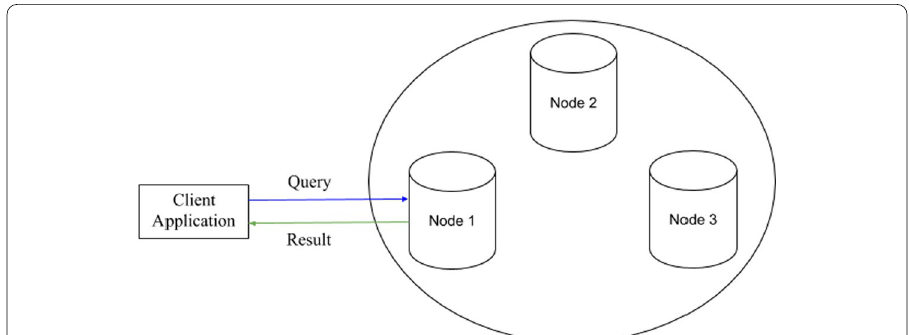
Fig. 2 Query execution path when cluster node owns partition of data requested by client